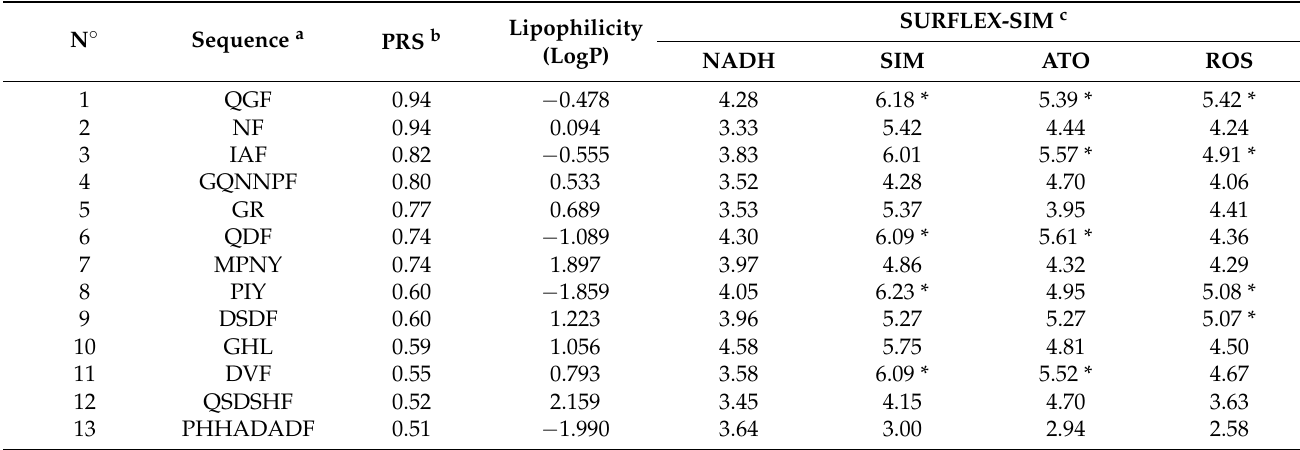
a Peptide sequences were obtained from BIOPEP analysis, as described in the Materials and Methods Section. b PRS = PeptideRanker score (see Table 1). c Similarity score calculated by SURFLEX-SIM, ranging from 0.0 to 10.0, that compares the interaction profile of each peptide with that expected for HMG-CoA reductase inhibitors or for the enzyme cofactor. Compounds with higher similarity scores for HMG-CoA reductase inhibitors than for the enzyme cofactor suggest that they have a higher probability of binding within the catalytic binding site than to the cofactor binding site. Peptides that scored among the top four (*), for at least two ligands were subjected to molecular docking